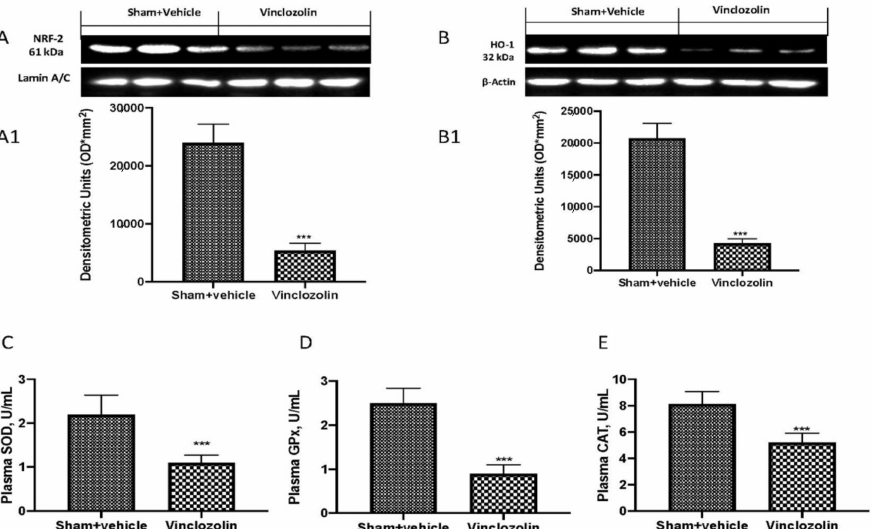
Figure 5. Vinclozolin-induced Nrf-2 pathway alteration. Western blots and quantification of NRF2 ( A , A1 ) and HO-1 ( B , B1 ) in lung tissue. ELISA kit results for SOD ( C ), GPx ( D ), and CAT ( E ) levels. Vinclozolin exposure induced a significant alteration in the Nrf-2 pathway with an imbalance in antioxidant defense. Values are the means ± SD of 6 mice per group. *** p < 0.001 vs. sham.